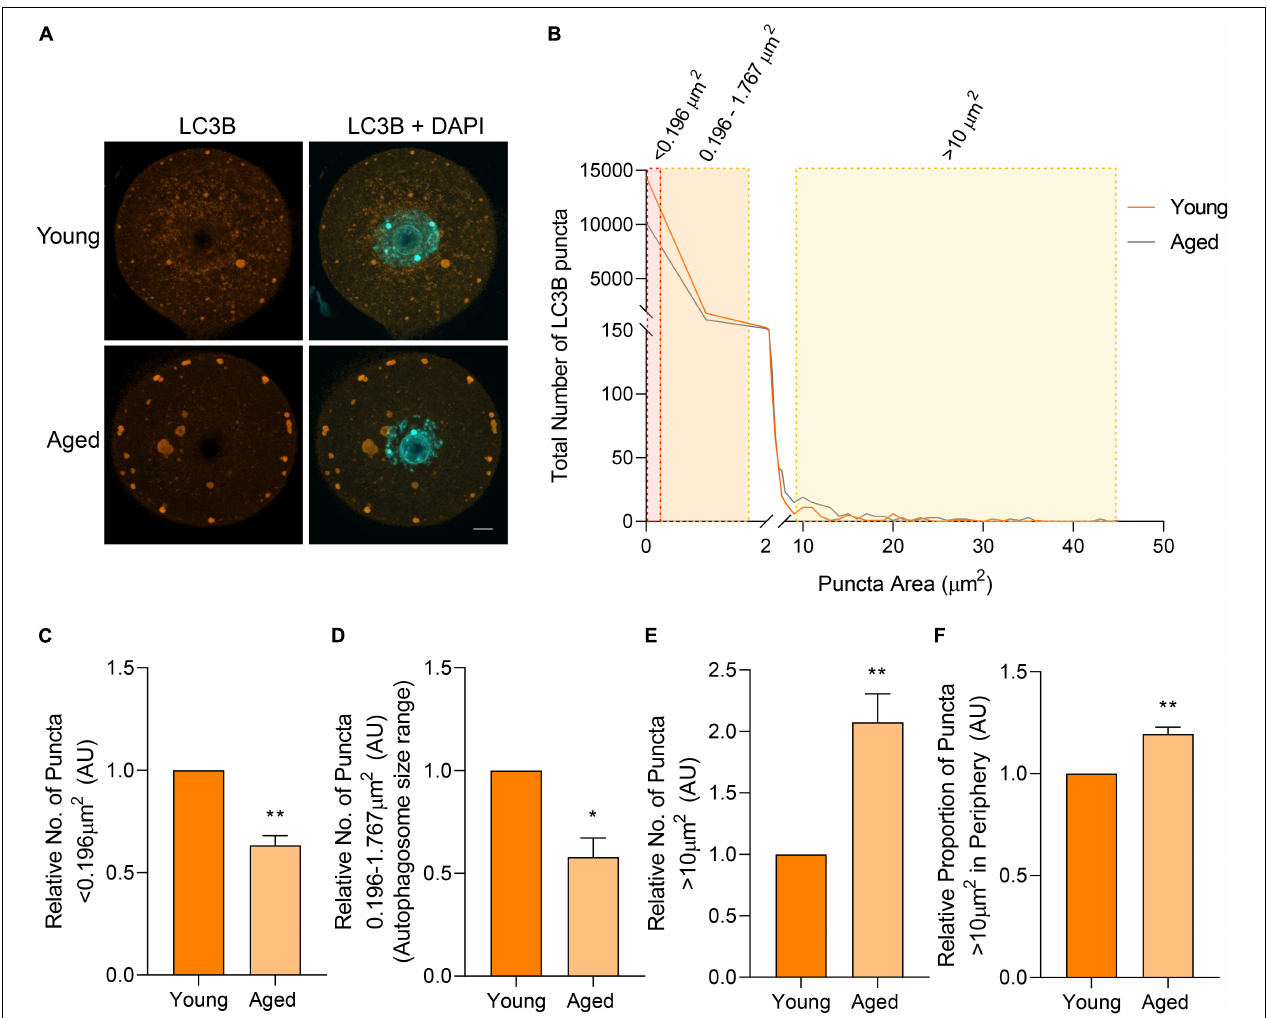
FIGURE 6 | LC3B protein localization and puncta distribution in young and aged mouse oocytes. Oocytes from young (4–6 weeks old) and aged (12–14 months old) mice were fixed prior to labeling with anti-LC3B antibodies (orange), nuclear counterstaining with DAPI (cyan), confocal imaging (60 × objective), and puncta analysis. (A) Representative images illustrate the punctate cytoplasmic localization of LC3B in young and aged oocytes. Scale bar = 10 µ m. (B) Images were assessed for the number and size of LC3B labeled puncta, and these data were used to graph the size distribution of puncta in populations of young (orange line) and aged oocytes (gray line). The puncta size groupings that differed significantly in abundance between young and aged oocytes are highlighted in red, orange, and yellow shading. (C) Comparison of the number of LC3B labeled puncta < 0.196 µ m 2 , (D) 0.196–1.767 µ m 2 [documented area of autophagosome (Mizushima et al., 2002)], (E) and > 10 µ m 2 in young and aged oocytes (normalized to young). (F) Comparison of the proportion of LC3B labeled puncta > 10 µ m 2 that resided in the periphery (outermost 10 µ m) of the oocyte (normalized to young). N = 3, * P < 0.05, ** P ≤